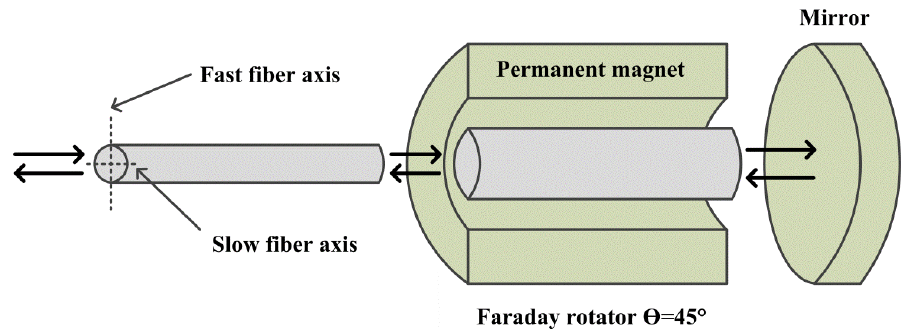
Figure 8. Faraday rotator